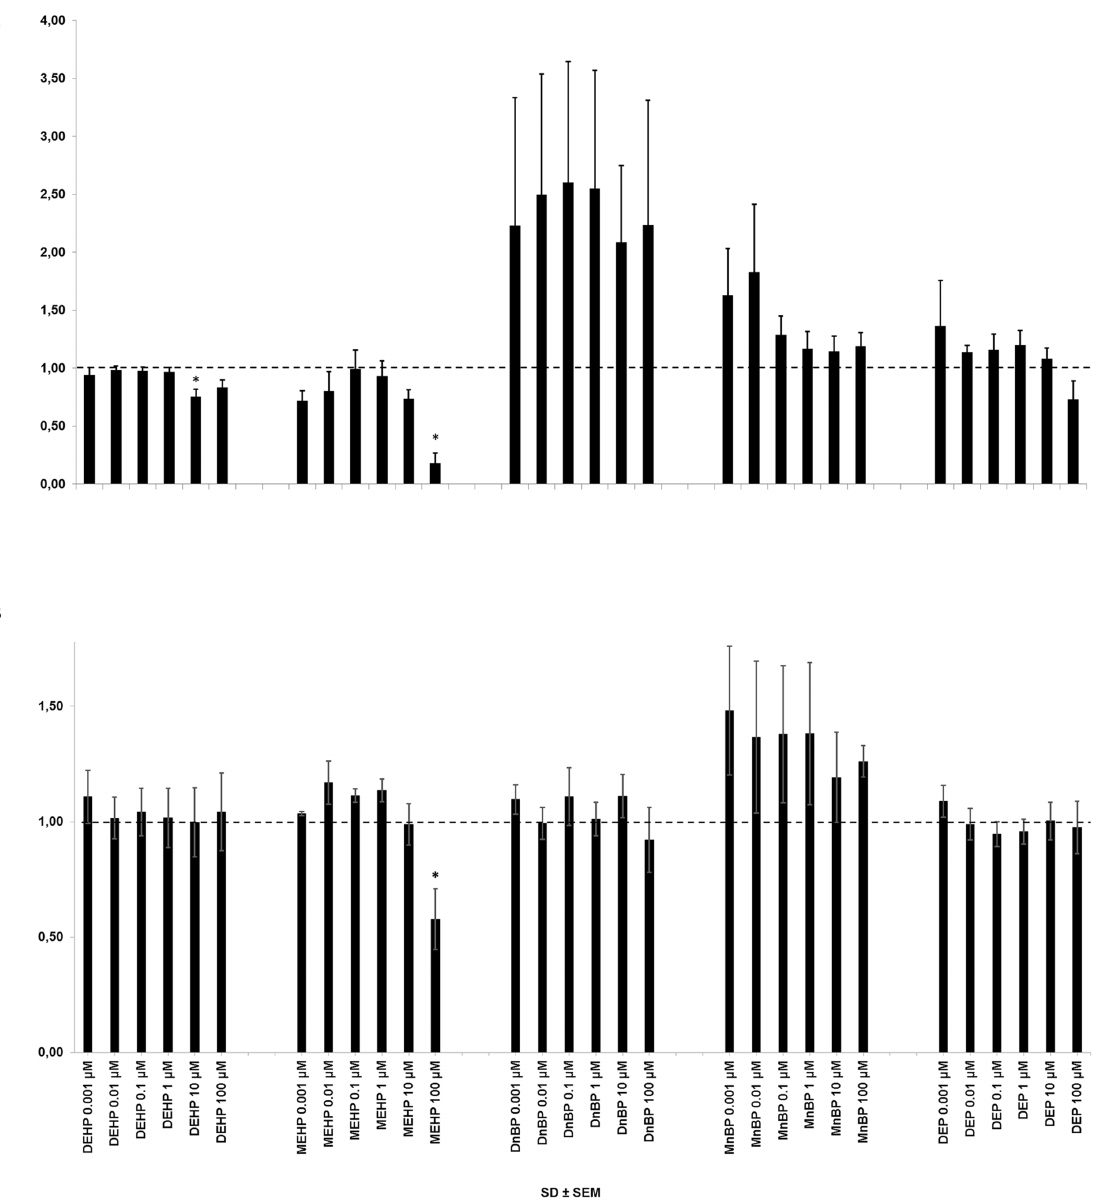
Fig 3. cAMP- (A) and Tg- (B) secretion from TSH-stimulated primary human thyroid cells. Cells were exposed to DEHP (n = 9 cultures in single determination), MEHP (n = 3 cultures in single determination), DnBP (n = 8 (A) or 10 (B) cultures in single determination or duplicates), MnBP (n = 6 (A) or 10 (B) cultures in single determination) or DEP (n = 6 (A) or 11 (B) cultures in single determination or duplicates) in six different concentrations (0.001 to 100 μ M) for 72 h. cAMP- and Tg-concentrations are expressed as ratio to the respective ethanol control. The dashed line indicates ratio = 1 (control levels). The measured median and range (parenthesis) of the ethanol controls was: 1.3 (0.2 – 4.4) μ M) for cAMP and 26,202 (176 – 87,923) μ g/L) for Tg. * p < 0.05 in ANOVA. cAMP: 3'-5'-cyclic adenosine monophosphate. DEHP: di-2-ethylhexyl phthalate. DEP: di-ethyl phthalate. DnBP: di-n-butyl phthalate. MEHP: